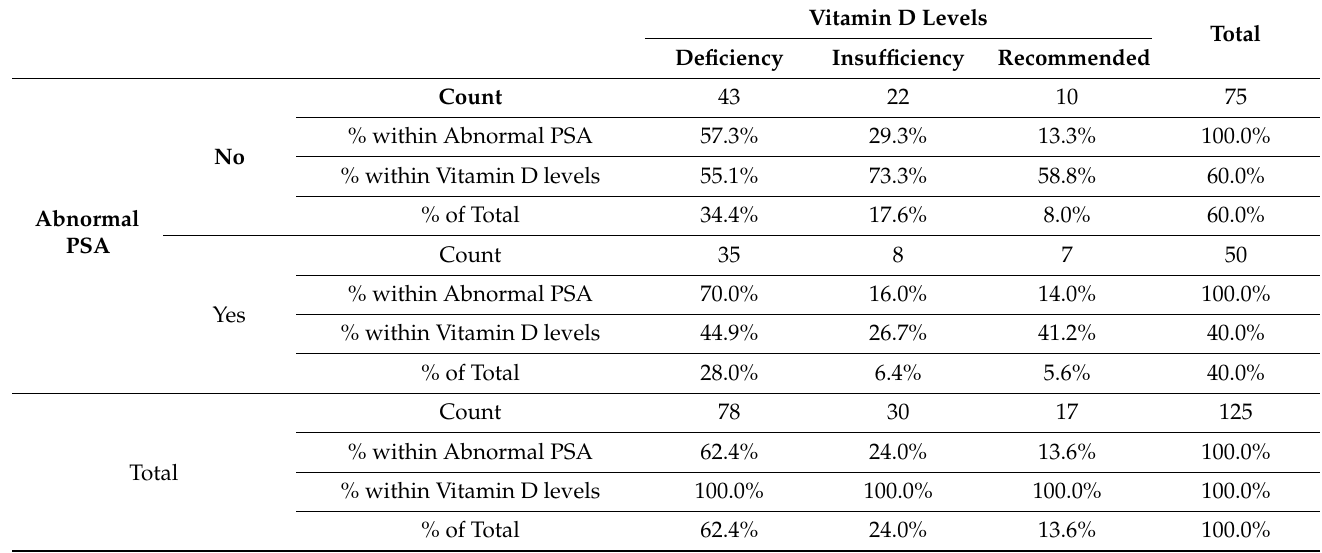
Table 2. Chi-square test among PSA categorical levels and vitamin D categorical